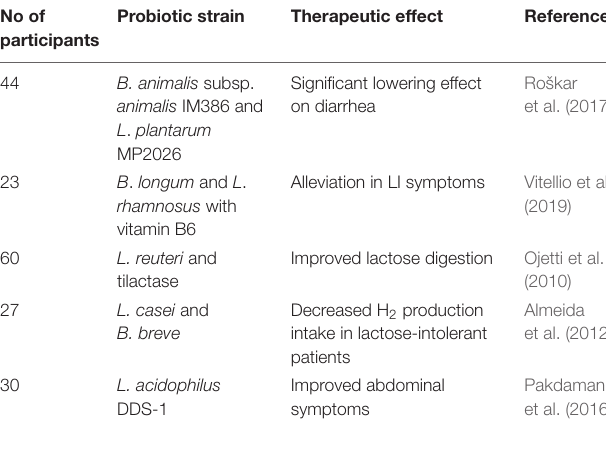
TABLE 1 | Probiotics against LI disorder: a list of the main available in vivo